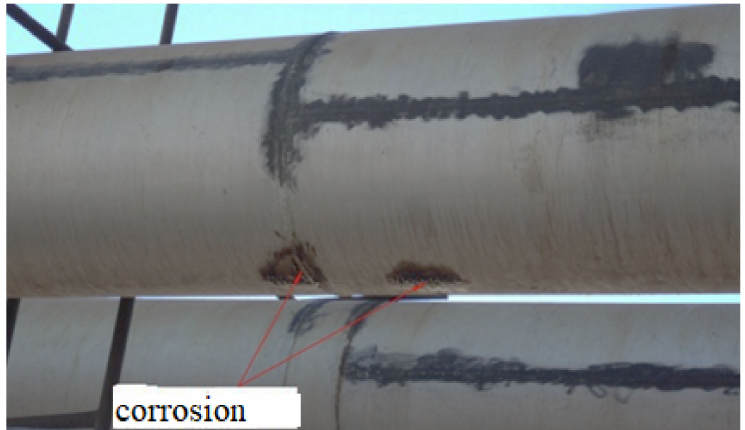
Figure 1. Pores in the pipes at the top of the distillation column (photo by Timur Chis).